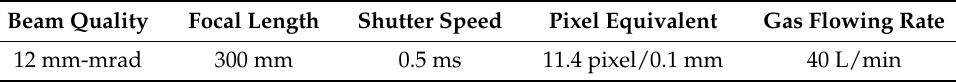
Figure 1. Schematic diagram of the experimental system. Table 1. Other laser welding conditions.